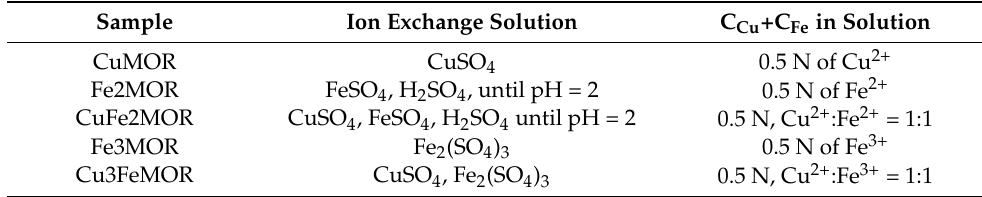
Table 5. Ion-exchange solutions preparation